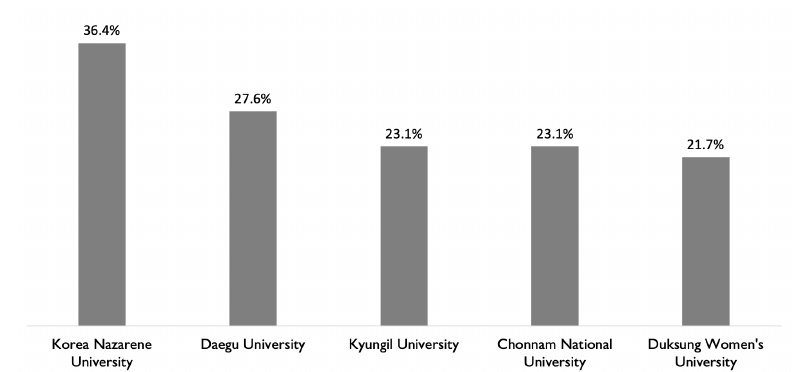
Figure 1. Top 5 universities with high frequencies of library/information center management-related courses.